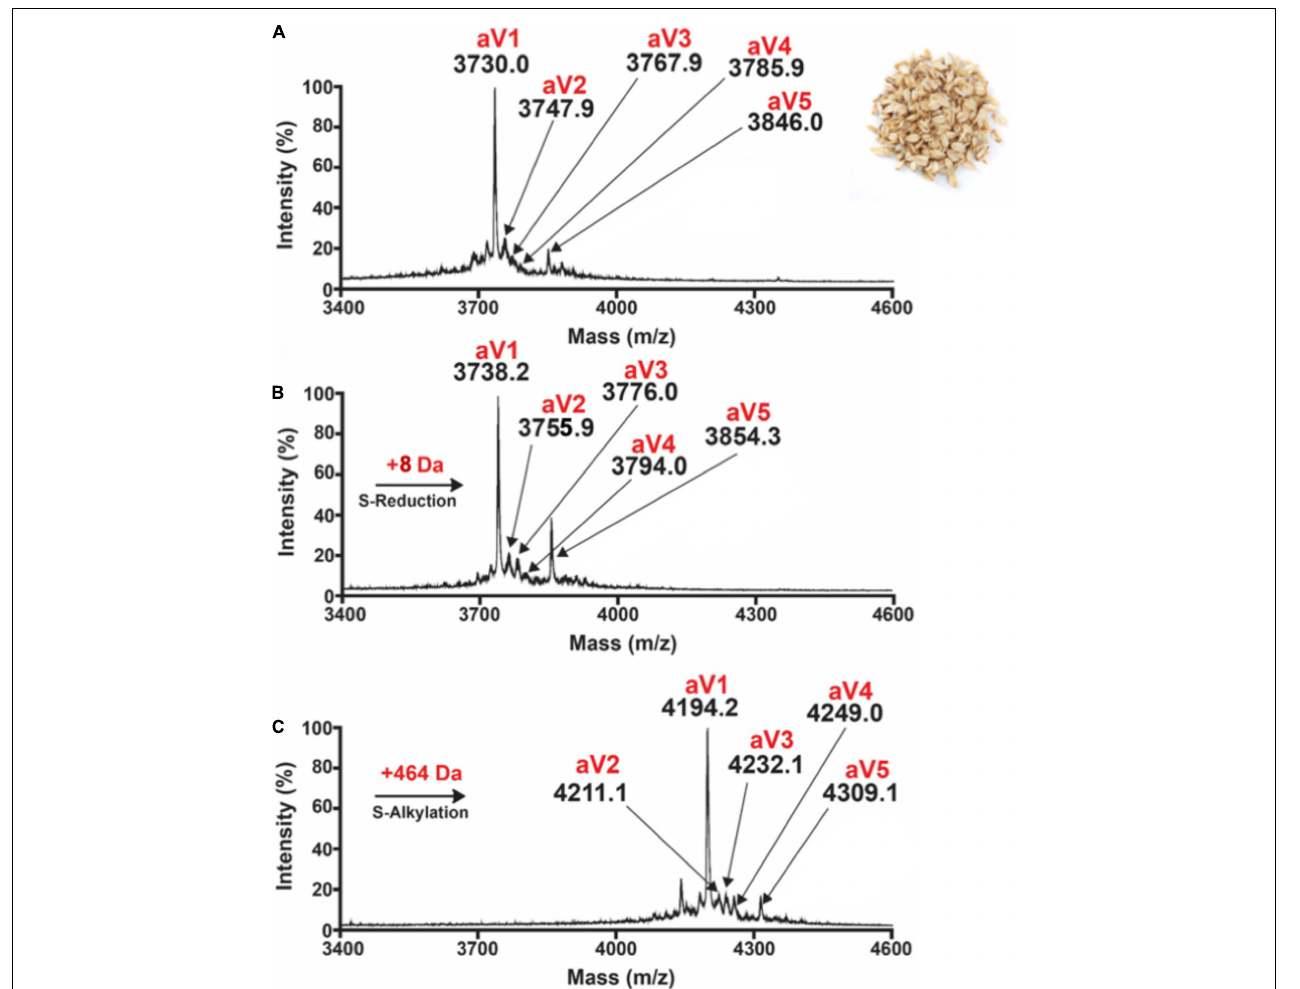
FIGURE 1 | MALDI-TOF MS profile of (A) aqueous oat extracts. Clusters of peaks between 2,000 and 4,000 Da indicate the presence of putative cysteine-rich peptides. Avenatides aV1–aV5 are labeled at corresponding peaks. (B) MALDI-TOF MS profile of aqueous oat extracts after S -reduction by DTT, and (C) S -alkylation by iodoacetamide (IAM) to give their corresponding linear forms and a gain of 58 Da for each S -alkylated Cys. Based on the increase of 464 Da, each avenatide is calculated to contain 8 cysteine residues.